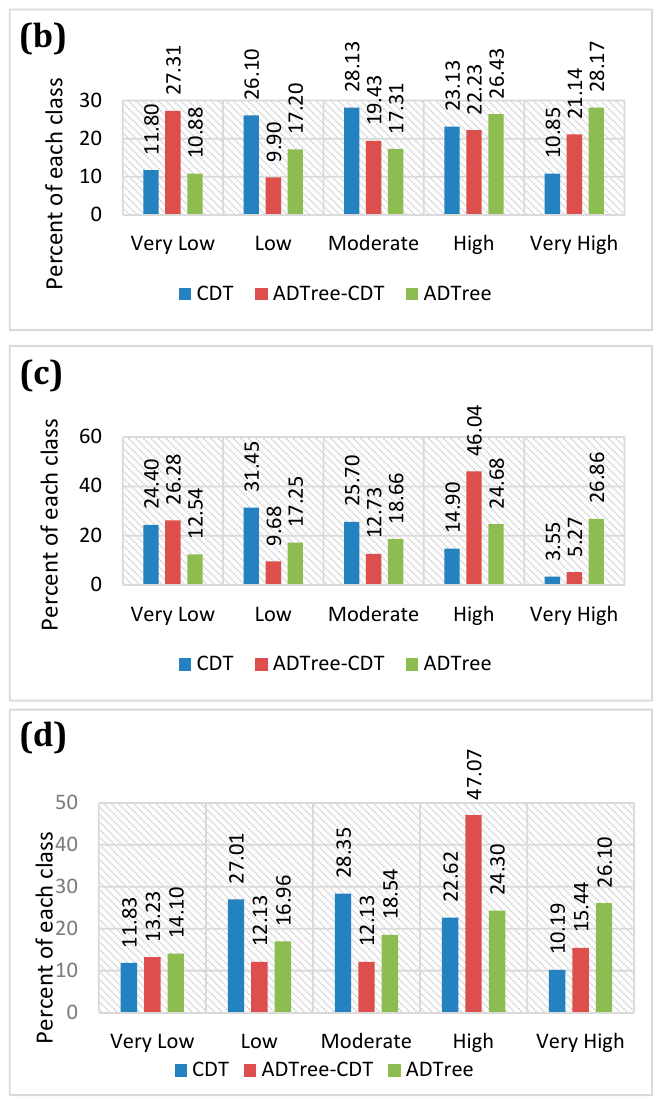
Figure 6. Percentage of each susceptibility class using ( a ) K-fold-1 for CDT, ADTree-CDT and ADTree, ( b ) K-fold-2 for CDT, ADTree-CDT and ADTree, ( c ) K-fold-3 for CDT, ADTree-CDT and ADTree, and ( d ) K-fold-4 for CDT, ADTree-CDT and ADTree.